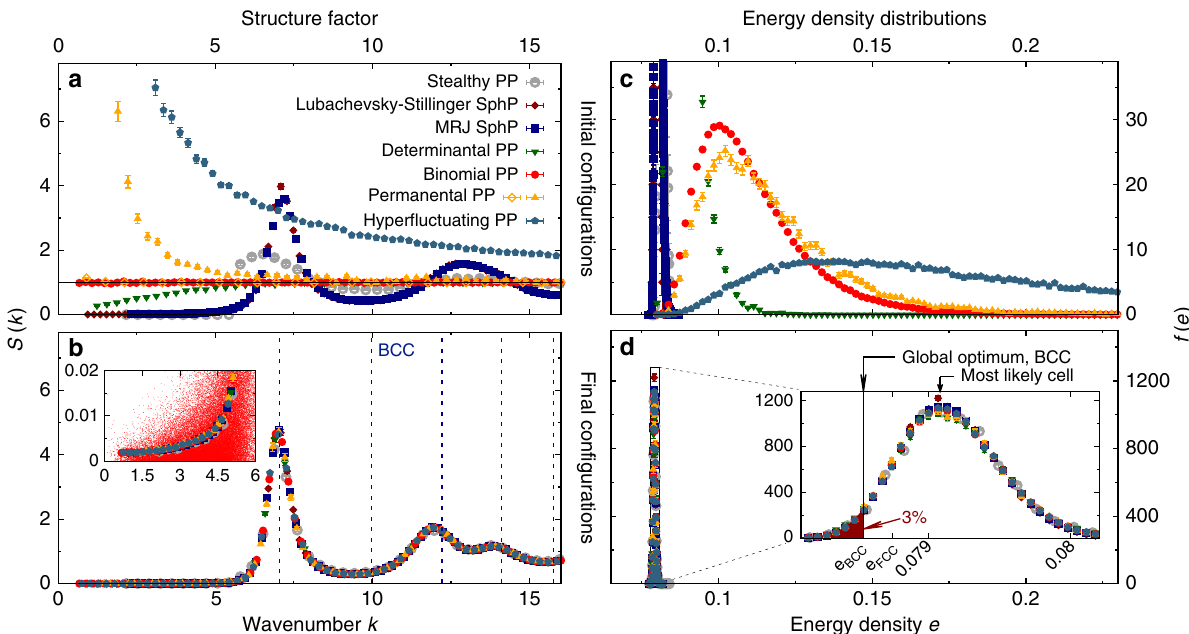
Fig. 3 Evidence supporting the universal effectively hyperuniform fi nal states in 3D. The structure factor S ( k ) is shown before ( a ) and after ( b ) application of Lloyd iterations. Different symbols represent different initial stochastic models, including anisotropic and hyper fl uctuating systems, and including point processes (PP) and sphere packings (SphP), see Methods section. For the fi nal con fi gurations, S ( k ) collapses within statistical errors and indicates effective hyperuniformity, in the inset the point cloud (red) shows the unbinned scattering intensity for all allowed wavenumbers for the largest sample (Binomial PP); for log-log plots, see Supplementary Figs. 8 and 9. Frequency distributions f ( e ) of cell energy densities e (see Methods section) are shown before ( c ) and after ( d ) application of Lloyd iterations; for a semi-log plot, see Supplementary Fig. 6. The distributions of energies after Lloyd iterations have mean 〈 e 〉 ≈ 1.008 × e e fi nal universal con fi gurations, there is a signi fi cant proportion ( ≈ 3%) of cells with a lower energy density BCC and FWHM 0.01 × BCC . In the than the crystalline optimal BCC structure. The error bars represent the standard error of the